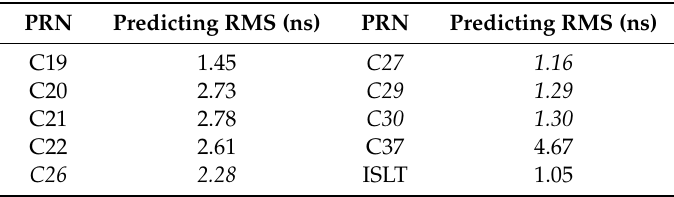
Table 5. Long-term clock prediction